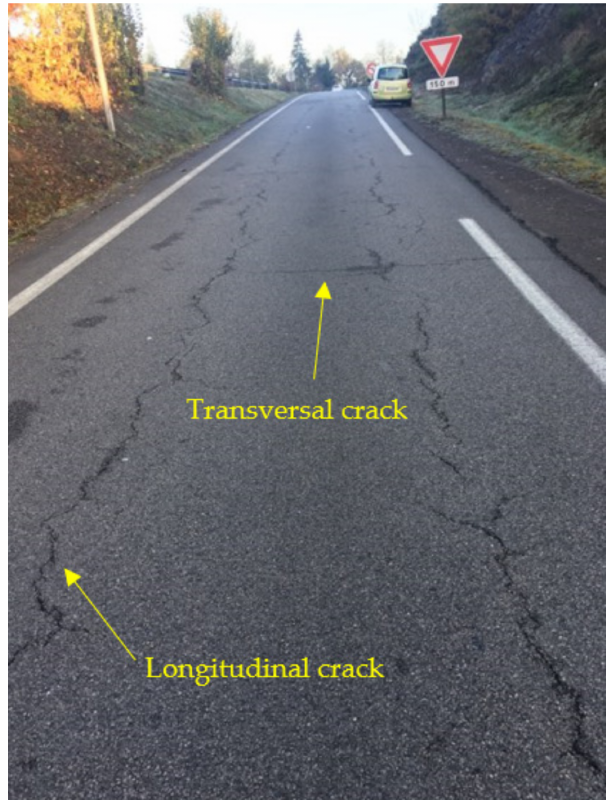
Figure 10. Cracking at the pavement